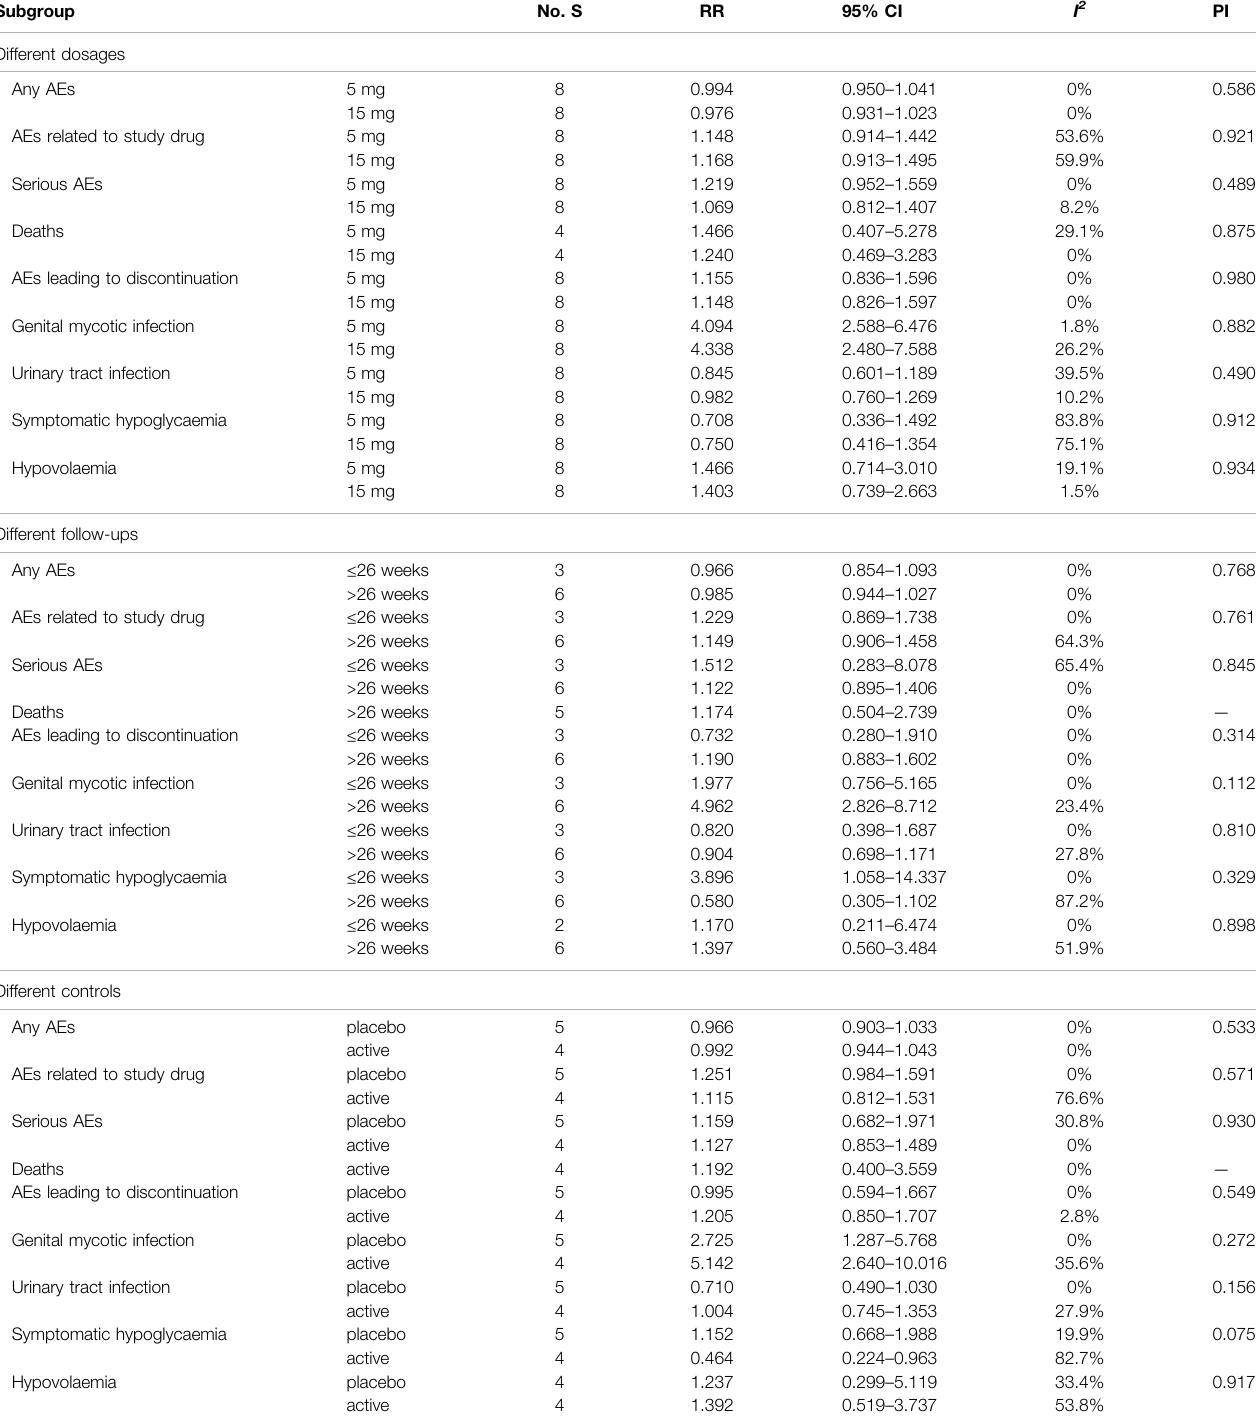
TABLE 3 | Subgroup analysis of main safety outcomes of ertugli fl ozin vs.